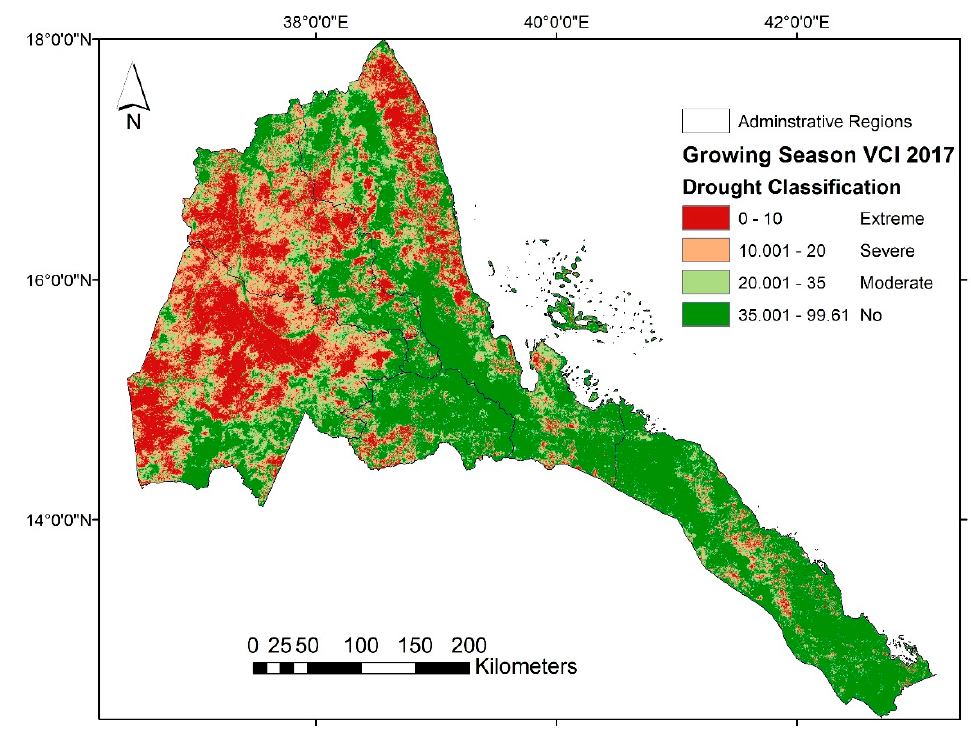
Figure 10. Mean Vegetation Condition Index (VCI ) drought classification for the main growing season of 2017.